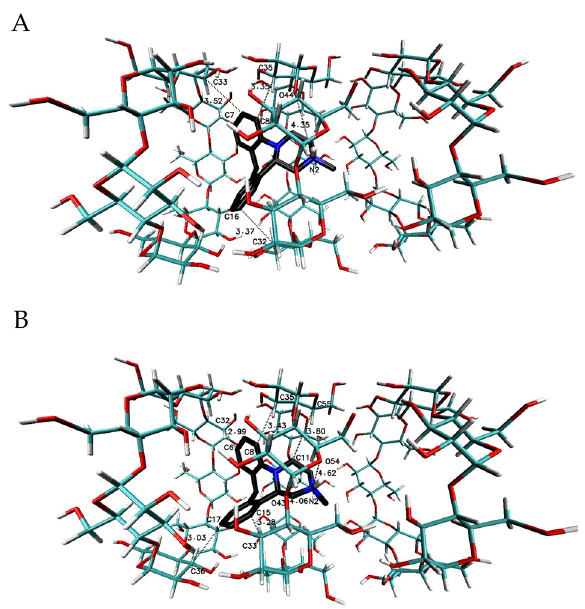
Figure 5. The chosen geometries of the MIA– β -CD complex with stoichiometry 1:3 (I-II-III or “head- to-head-to-tail” orientation of β -CD molecules to each other [36,37]) obtained by the Molecular Docking (MD) simulations, with the use of β -CD crystal structure with refcode 648855 from The Cambridge Structural Database (CSD) [38]; ( A ) for S-(+)-MIA ∙ HCl and ( B ) for R-( − )-MIA ∙ HCl.